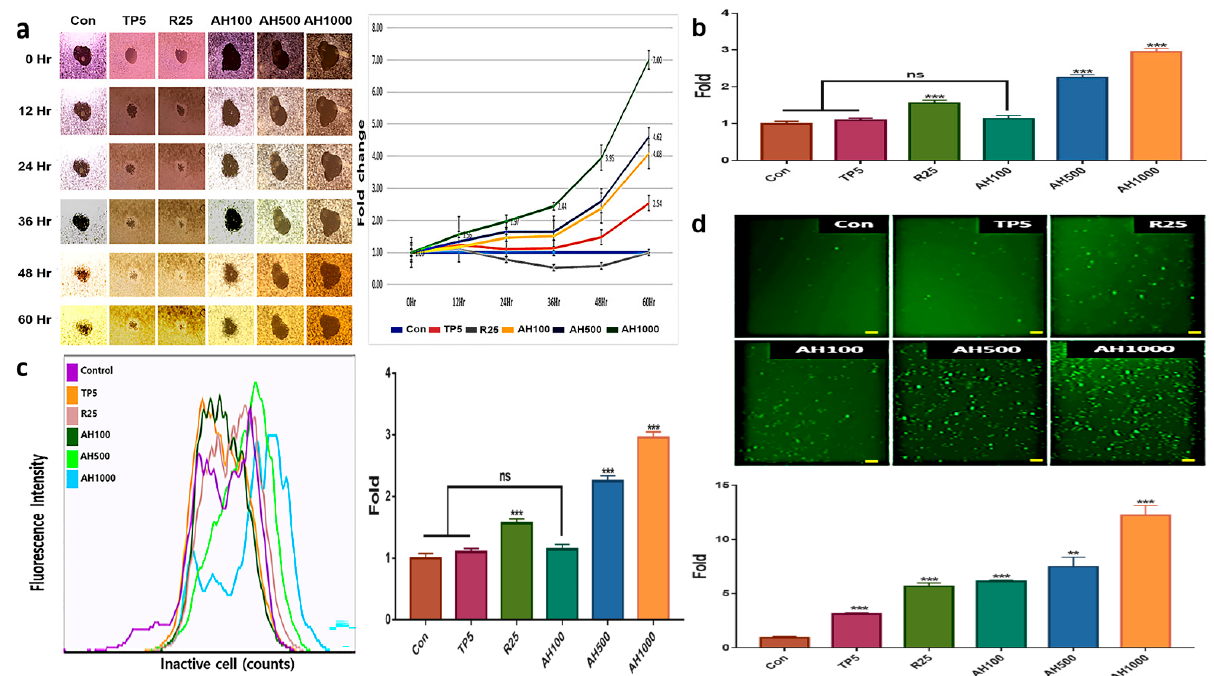
Figure 2. Inhibition of tumor activity by bioactive substances in endometrial cancer (EC) cells; ( a ) The central areas indicate the unseeded spaces with EC cells. The sizes were inversely proportional to EC cell migration. The areas were measured using Nikon software and the measured values indicate the relative fold changes. ( b ) The bar graphs indicate the non-invasive cells in the presence of 5 µ g/mL tocopherol- α (TP5), 25 µ g/mL rutin (R25), and 100, 500, and 1000 µ g/mL A. helianthus extract (AH100, AH500, and AH1000, respectively). ( c ) The specific fluorescence indicates inactive cells using mitochondrial membrane potential. ( d ) The senescenced cells were stained with green fluorescent dye, and the stained cells were counted using a flow cytometer, (scale bars = 100 µ m). ns: not significant; ** p < 0.01; *** p <